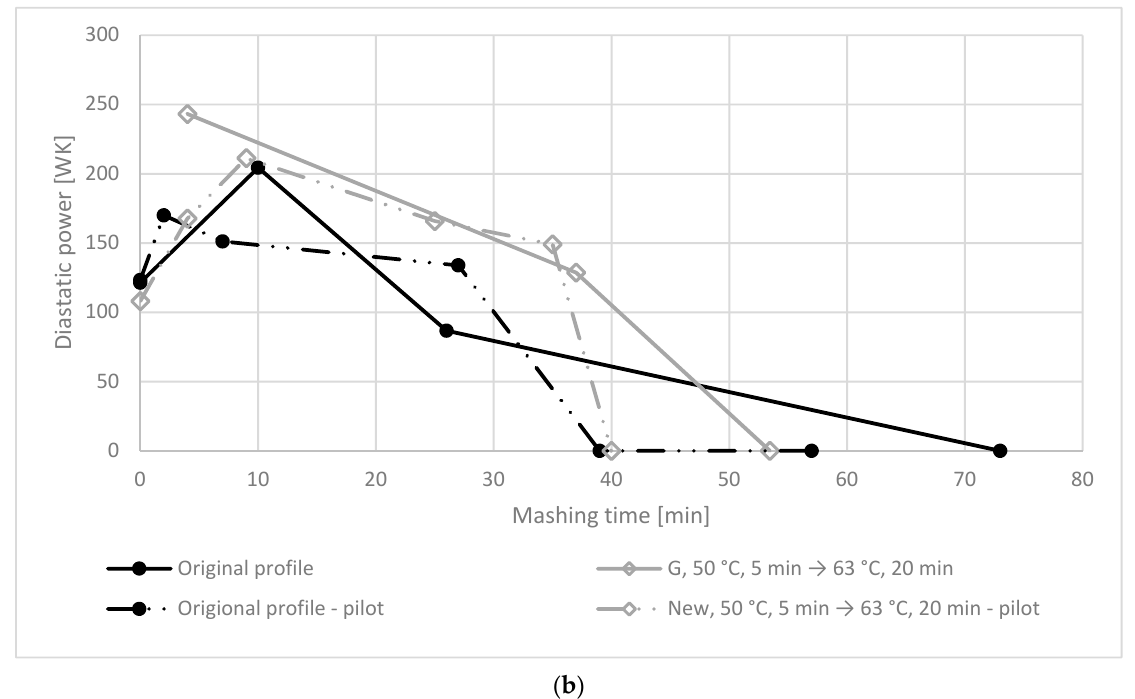
Figure 2. ( a ) α -Amylase and ( b ) β -Amylase activity of the different mashing profiles studied at pilot scale, compared to the same time-temperature profiles at lab scale measured with Brewer’s Dream™ kits. The heating rate was 1 °C/min for lab-scale experiments, and 2 °C/min for pilot-scale experiments. Mash out temperature was 78 °C, which was held for 1 min.